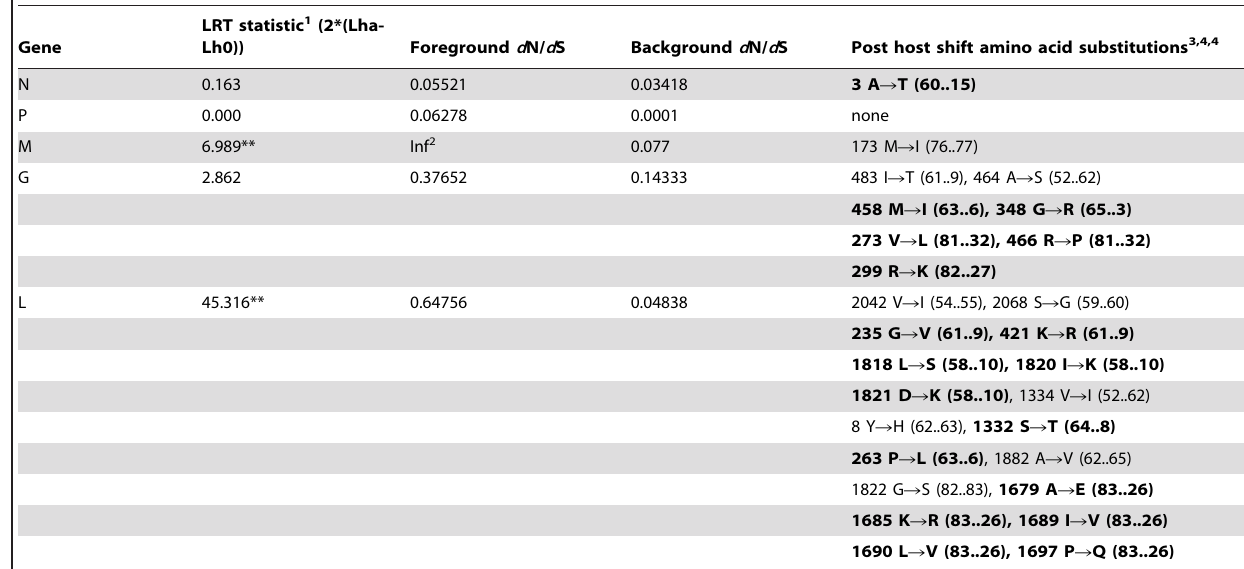
Table 1. Test results for positive selection analysis, and summary of amino acid